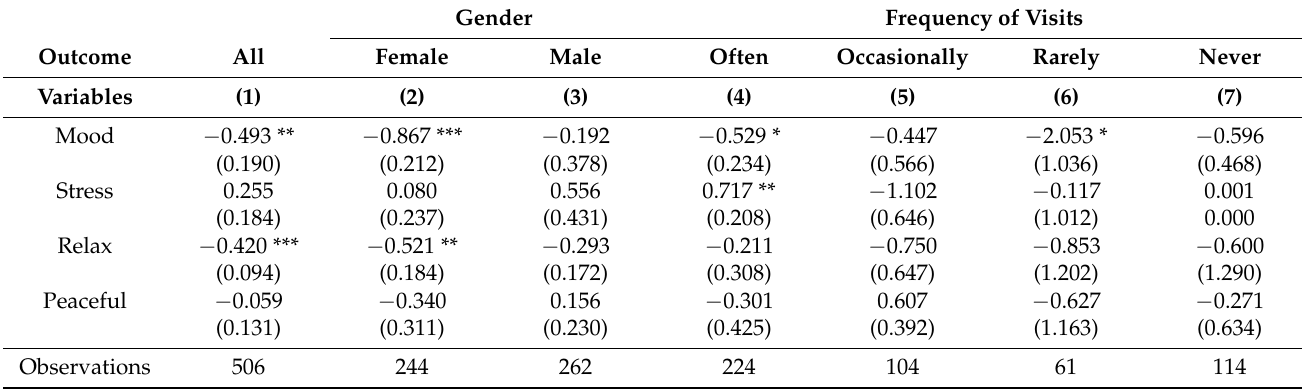
Table 1. Changes in self-reported affective experience produced by the increased number of public users in a green street, by gender and frequency of visit. Gender Frequency of